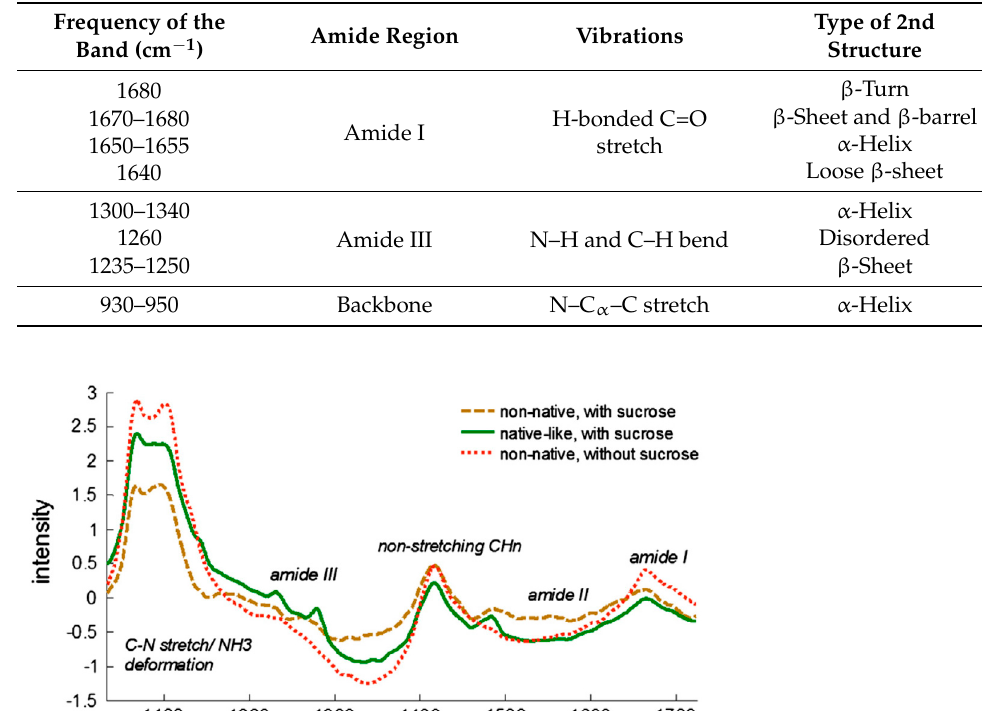
Table 1. Characteristic amide band frequencies and their associated secondary structures [64].